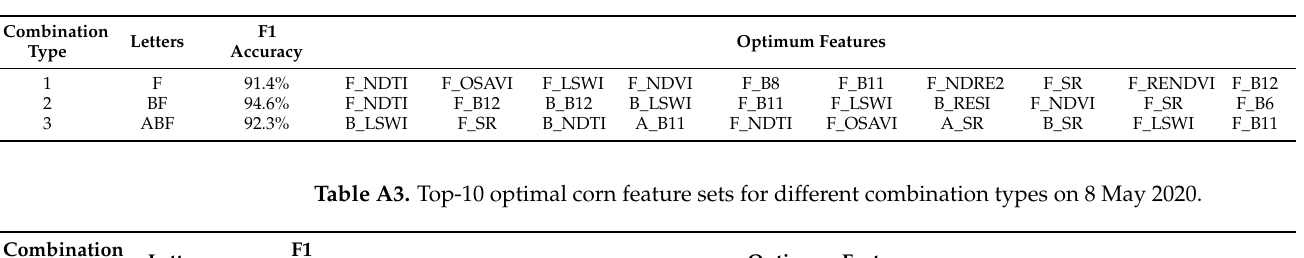
Table A2. Top-10 optimal rice feature sets for different combination types on 13 May 2020.